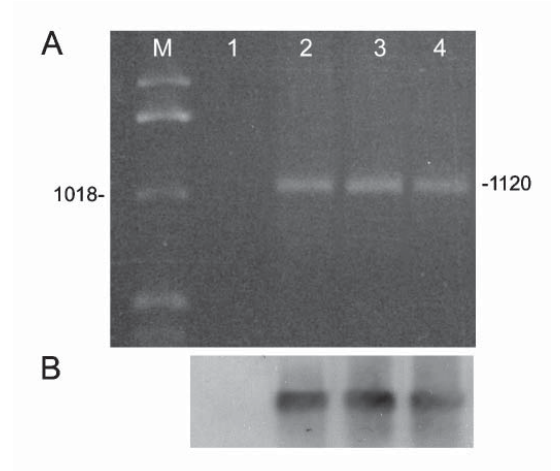
Fig 1. Identification of pac 1 gene in genomic DNA of potato transformed plants (cv. Desirée). A, 1.2% agar- ose gel electrophoresis of PCR products: M, DNA molec- ular weight marker; 1 untransformed potato; 2, 3 pota- to transformed clones (A and B, respectively); 4 positive control (pBI121- pac 1). B, hybridization of the above PCR bands with the specific digoxigenin-labelled pac 1 probe.